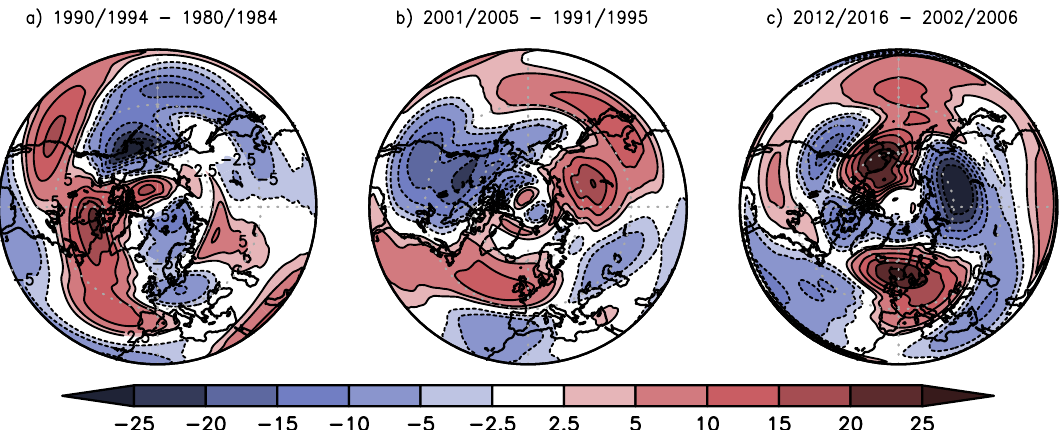
Figure 6. Trend-like pattern determined by the difference of 5-year means of ZATO in [DU/decade] for January but using the linear transport model results with contributions of wave 1–4. Table 1. Pattern correlation of the trend-like pattern of ZATO for 25 ◦ N–90 ◦ N for observations